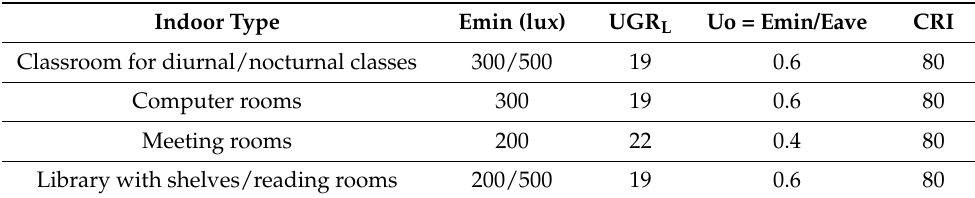
Table 3. Minimum levels of photopic illumination according to UNE 12464–1 [38], min = Eminimum, Eave =